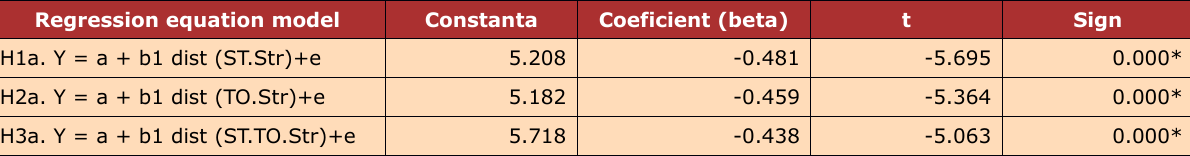
Table 6. The result of Hypothesis Testing Proactive Strategy (n = 110)